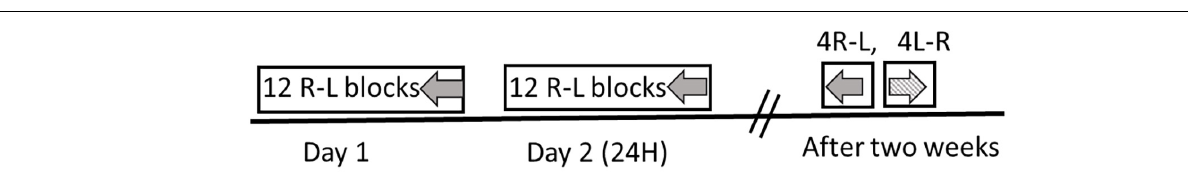
digitizer in front of the participant for completion. The same task was repeated for the practice sessions during the three